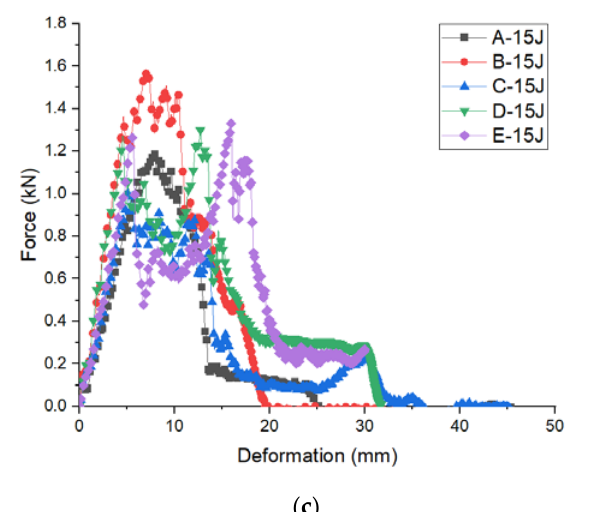
Figure 5. Force-deformation curves of five groups of 3D integrated woven spacer sandwich composites under different impact energy levels ( a ) 5 J, ( b ) 10 J, ( c ) 15 J.